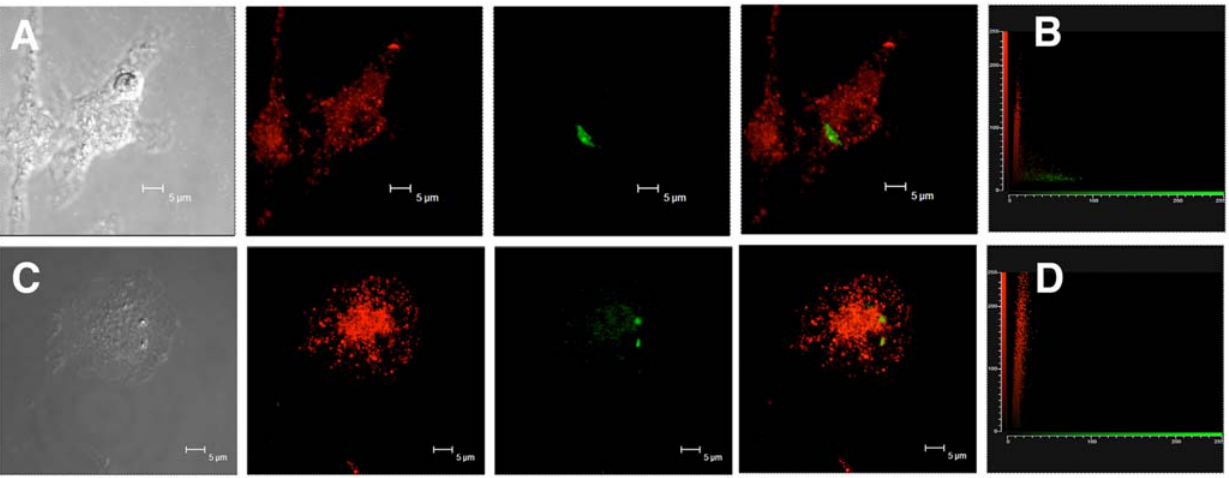
Figure 3. TLF surrounds parasites in the PV but is not endocytosed by L.major . Bone-marrow derived macrophages were infected with GFP- L. major parasites (green) for 2 hours before treatment with prelabelled-Alexa 594-TLF ((10 m g/ml) red) for 2 hours (A) and 24 hours (C). The grey panels are transmission light micrographs of the imaged macrophages. The lack of colocalisation of the two dyes (red and green) is revealed by the 2D cytoflurograms of 25 z-stacks (2 hours, B) and (24 hours, D). Samples were visualized and analyzed with a Leica TCS SP2 AOBS confocal laser scanning microscope.